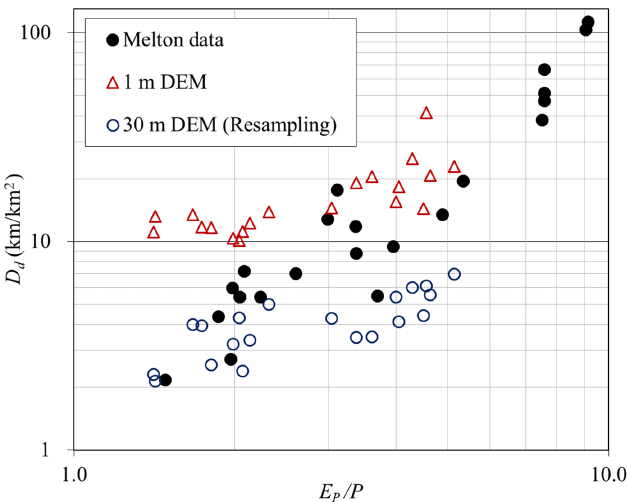
Figure 7. Drainage densities ( D d ) derived from LiDAR-based 1 m DEM and its resampled 30 m DEM.